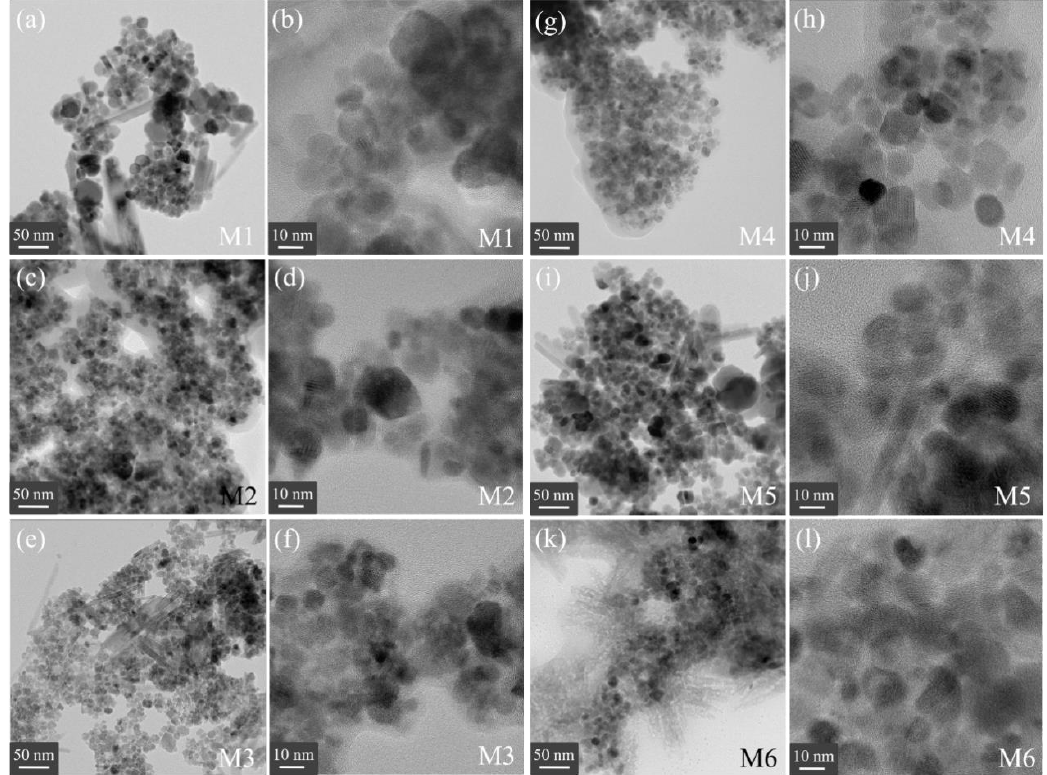
Table 1. TEM values for mean particle diameter and D m is the mode value obtained from the PSD histogram.